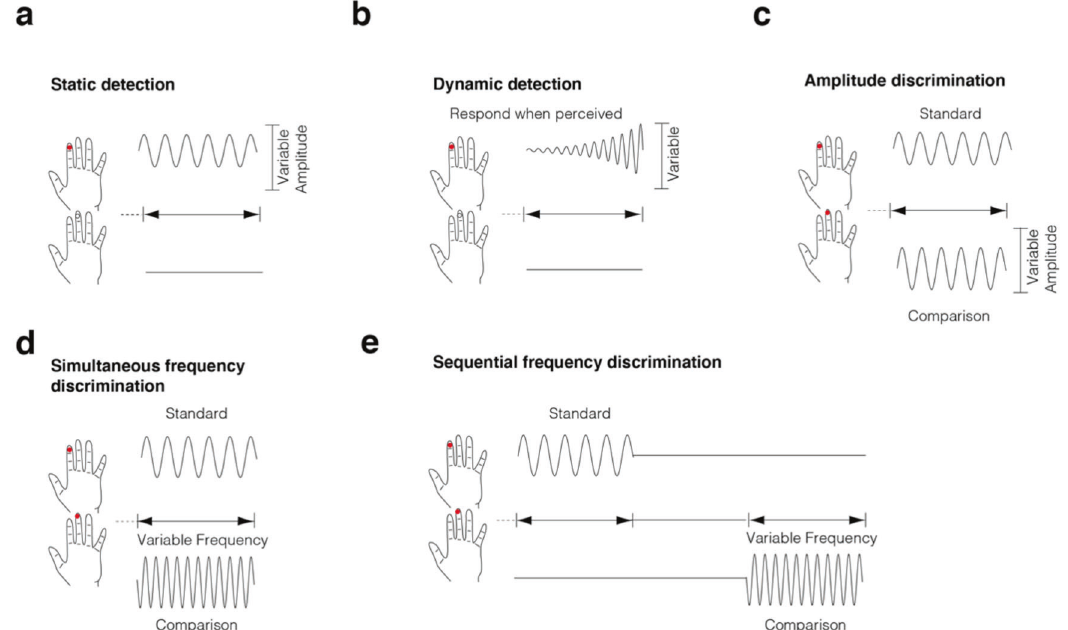
Fig. 2 Visual schematic of relevant tasks from the vibrotactile battery. a Static detection protocol in which participants must detect which fi nger (left digit 1 or left digit 2) received the stimulation. Stimuli are presented with a fi xed frequency and an amplitude that is increased or decreased based on incorrect and correct responses respectively. b Dynamic detection protocol in which participants are instructed to respond immediately after they perceive a stimulus of increasing amplitude. c Amplitude discrimination protocol in which a standard stimulus with a fi xed amplitude and frequency is compared to a comparison stimulus in which the amplitude varies based on performance (i.e., the difference in amplitudes between the standard and comparison stimulus is increased following an incorrect response but decreases following an incorrect response). d Simultaneous frequency discrimination, similar to the amplitude discrimination protocol but rather than the stimulus amplitude changing based on performance, frequency of the comparison stimulus changes instead. e Sequential frequency discrimination, like the simultaneous frequency discrimination but stimuli are delivered sequentially (requiring less lateral inhibition and likely requires more accurate temporary storage of stimulus characteristic for later comparison). Full details about the parameters and timing of the stimuli are provided in Supplementary